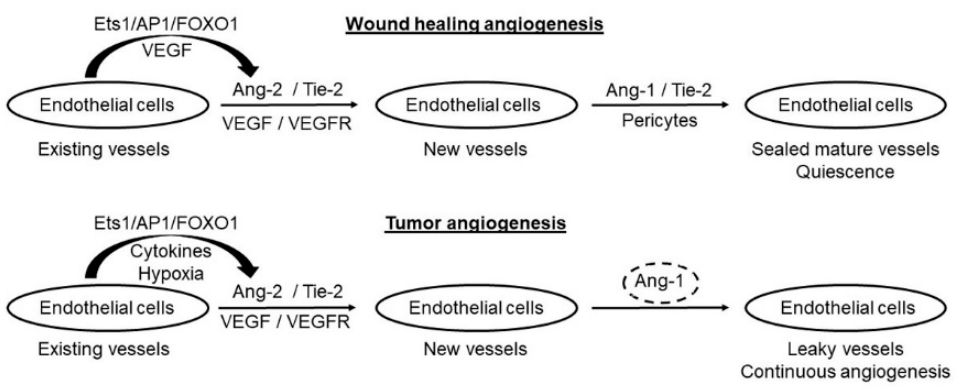
Figure 1. Differences between wound healing angiogenesis and tumor angiogenesis. With constant production of high levels of Ang-2, tumor angiogenesis is a continuous process that supports tumor growth and progression. In contrast, Ang-2 is only transiently induced during injury, and angiogenesis is halted right after wound healing. Secondly, high levels of Ang-1 assures maturation and “sealing” of newly generated blood vessels by recruiting pericytes during wound healing. However, due to insufficient levels of Ang-1 in cancer patients, tumor angiogenesis generates unsealed “leaky” blood vessels.